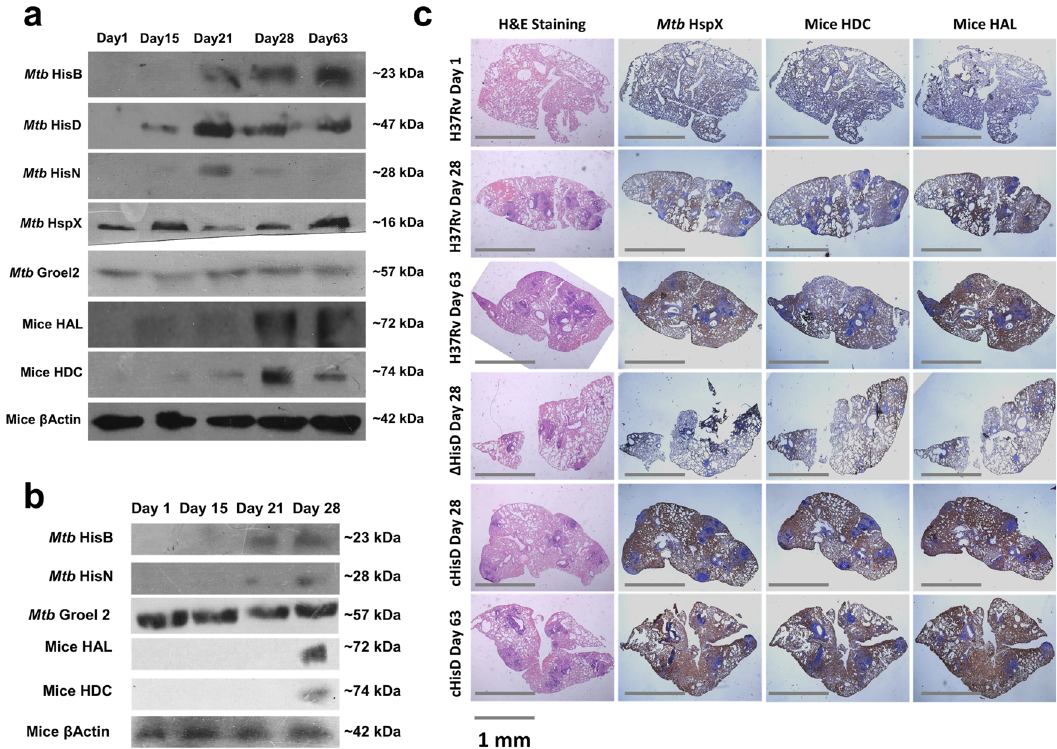
Fig. 2 A concomitant increase in host histidine sequestering enzymes and Mtb histidine biosynthesis enzymes. a Immunoblots depict a noticeable rise in the expression levels of histidine catabolizing enzymes HAL and HDC in the whole lungs lysate sample of H37Rv-infected B6 mice over a period of 9 weeks. A similar rise in the Mtb histidine biosynthesis enzymes HisB, HisD and HisN is also observed. Mice β -Actin and Mtb Groel2 serve as loading controls. Mtb HspX serve as an indicator of infection. (Immunoblots are representative of samples obtained from nine mice for each time point). b Immunoblots depicting a comparable rise in the expression levels of host histidine catabolizing enzymes and Mtb histidine biosynthesis enzymes in whole lungs lysate samples of Δ hisD- infected B6 mice over a period of 4 weeks (immunoblots are representative of samples obtained from nine mice each time point). c Immunohistochemical analysis exhibiting co-localised expression of mice HAL, mice HDC and Mtb HspX suggesting compartmentalised expression of host histidine sequestering enzymes limited to lung lesions. (Expression is depicted in bright blue colour. Pictures are representative of samples obtained from nine mice for each time